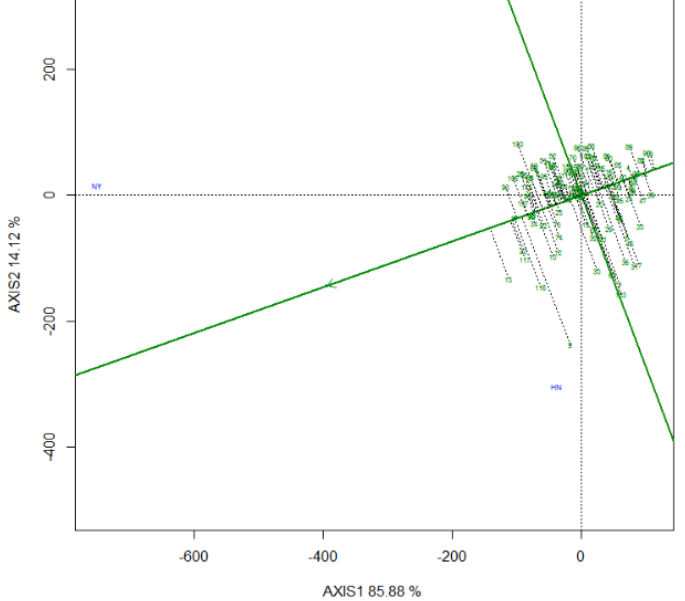
Figure 3. Height (H) mean and stability. The average environment axis, with a single arrow, points to the genotype’s approximate average yield in all environments. The G × E interaction is shown by the vertical dashed line between the genotype and the mean environment axes. Longer dashes indicate a less stable seedling H (yield) [14]. Same as in Figure 6.